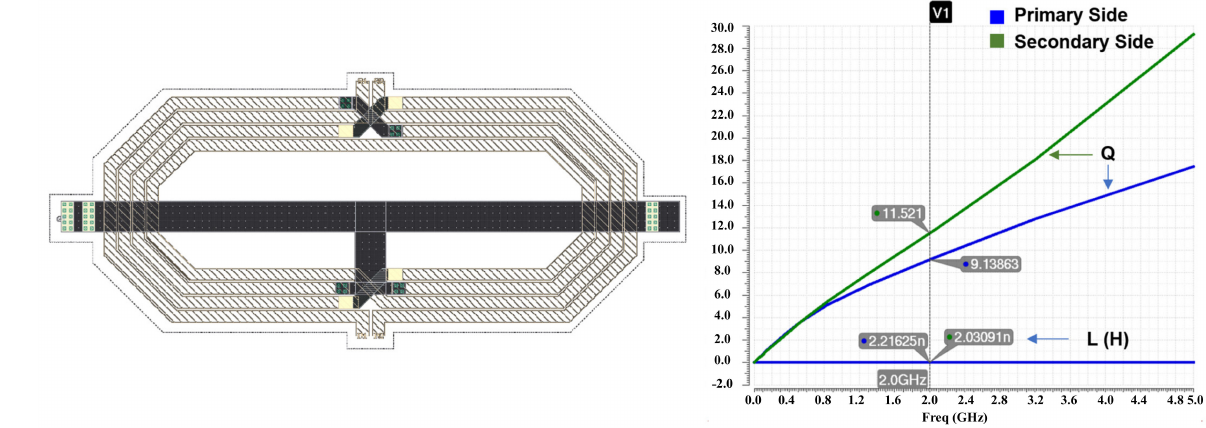
Figure 6. The designed center-tapped (CT) HB balun with Q and L simulations for both the primary and secondary sides.